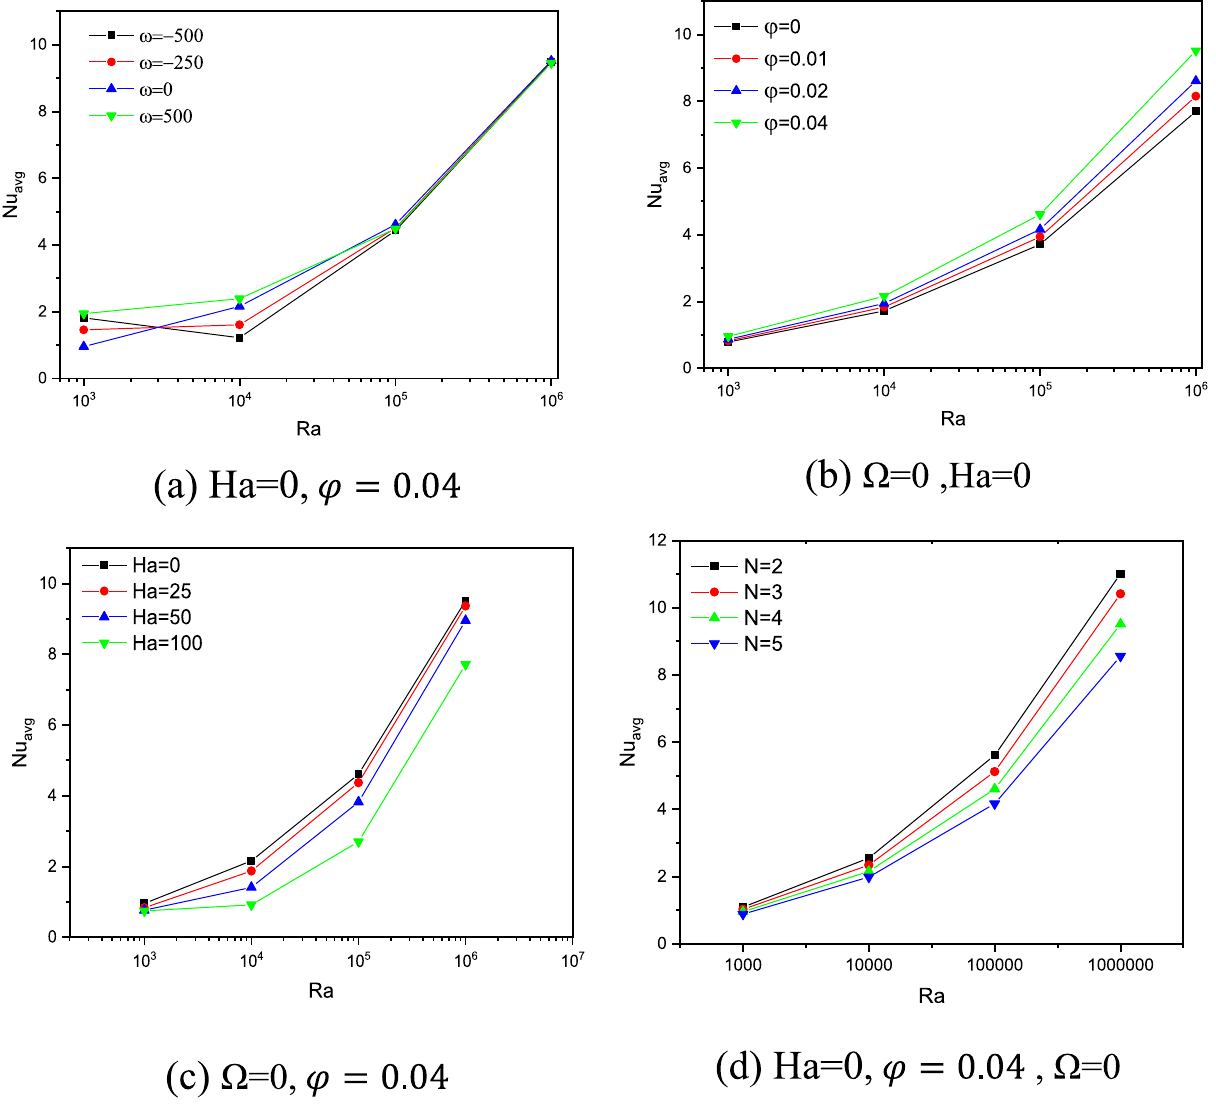
Figure 7. Impact of Ra on Nu avg with varying Ω ( a ), ϕ ( b ) and Ha ( c ) at N = 4, N ( d